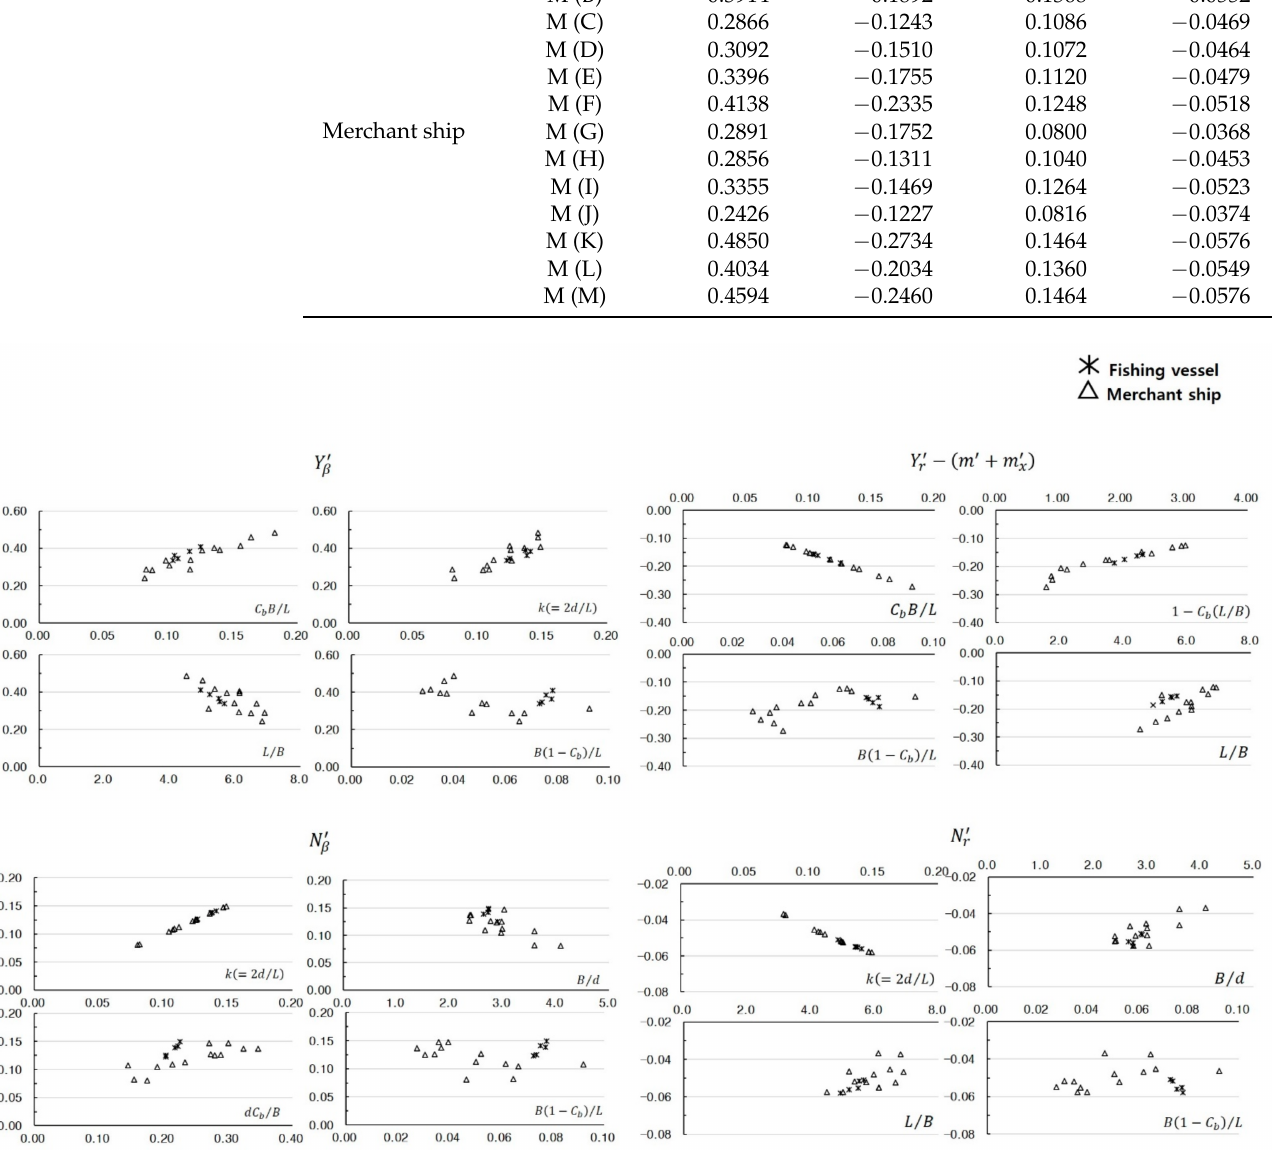
Figure 3. Correlation diagram between linear hydrodynamic coefficients and characteristics of hull shape